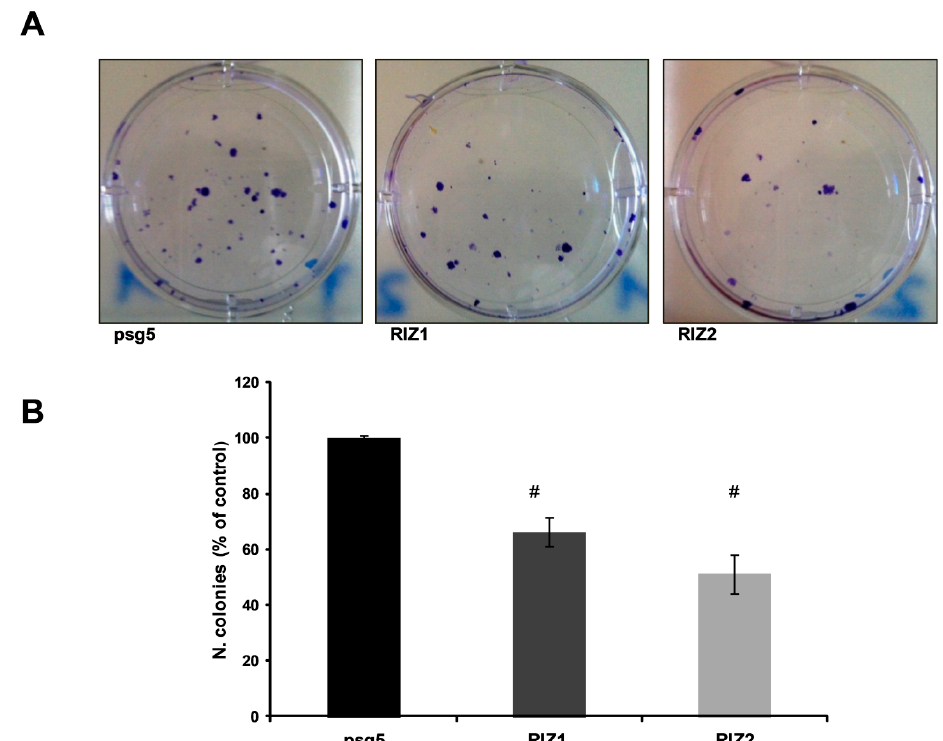
Figure 4. Role of RIZ in GC-1 tumor growth. ( A ) GC-1 cells transiently transfected with indicated vectors, were seeded into 6-well plates. Fifteen days later the clones were fixed at room temperature with a solution containing 0.5% crystal violet/6% glutaraldehyde (Sigma-Aldrich) for 30 minutes. Clones were counted and their cellularity was evaluated by contrast microscopy; ( B ) The histograms represent the averages of colonies from four separate experiments performed in duplicate ( n = 8). # p < 0.05 vs. control).